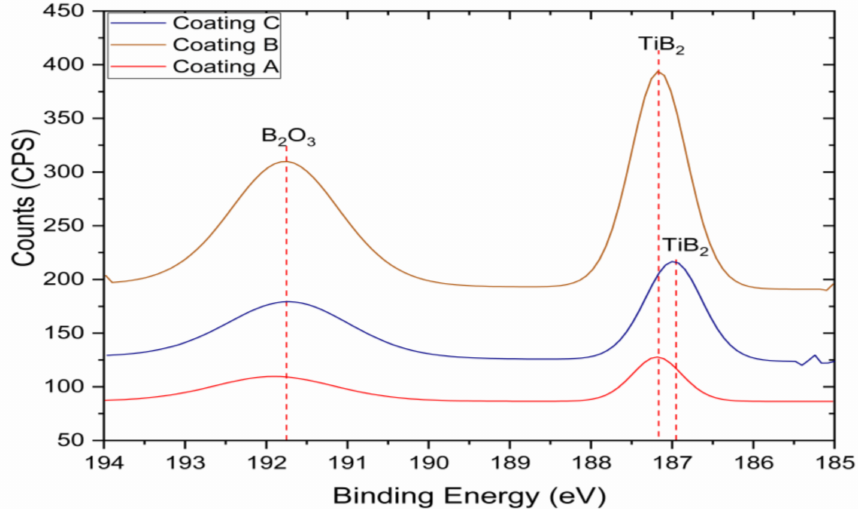
Figure 17. High resolution XPS data (B 1s spectrum) of worn rake surface of the three TiB 2 coatings confirming B 2 O 3 tribo-oxide